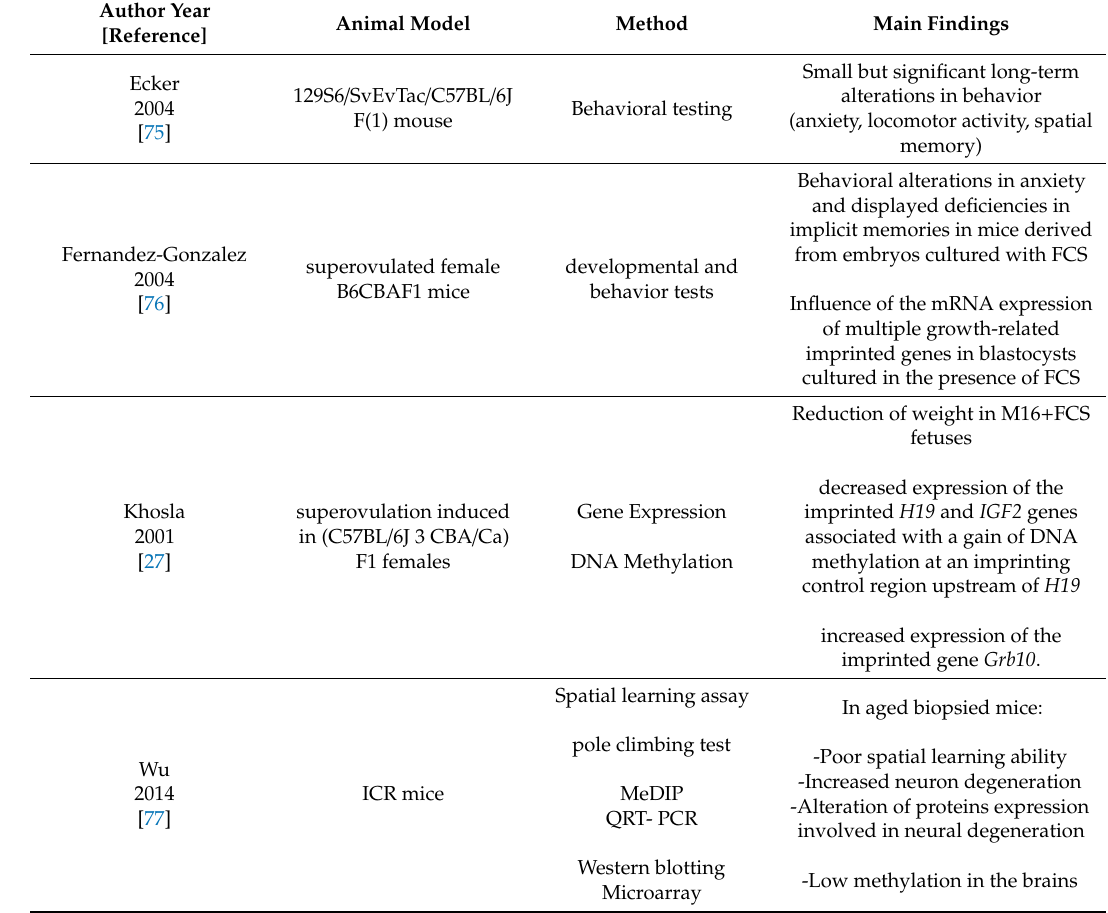
Table 1. Rodent studies related to neural development derived from cultured